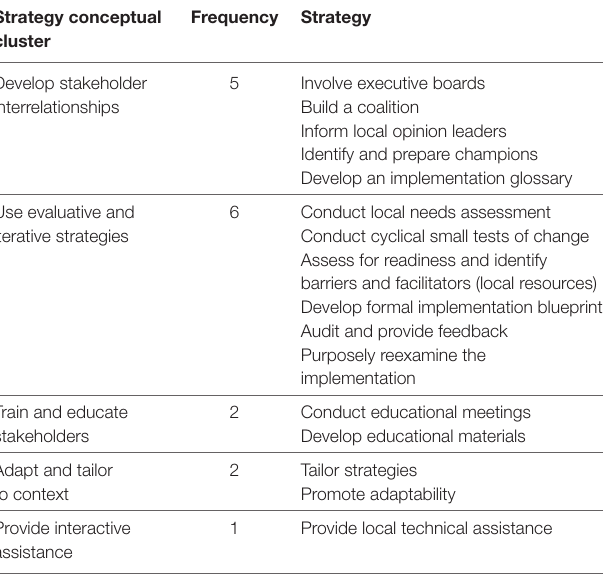
tABle 4 | Number of implementation strategies by conceptual cluster (10). strategy conceptual